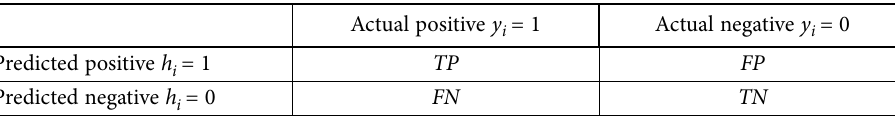
Table 1. Classification matrix Actual positive y i = 1 Actual negative y i = 0 Predicted positive h i = 1 TP FP Predicted negative h i = 0 FN